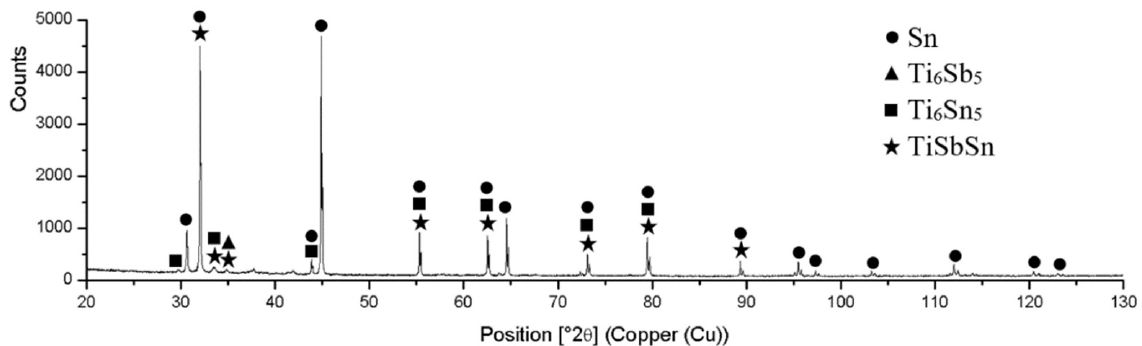
Figure 13 . XRD analysis of the Sn5Sb3Ti solder. The planar distribution of titanium and antimony phases Ti 6 (Sb,Sn) 5 and TiSbSn in the tin matrix with a low Sb content is documented in Figure 14.